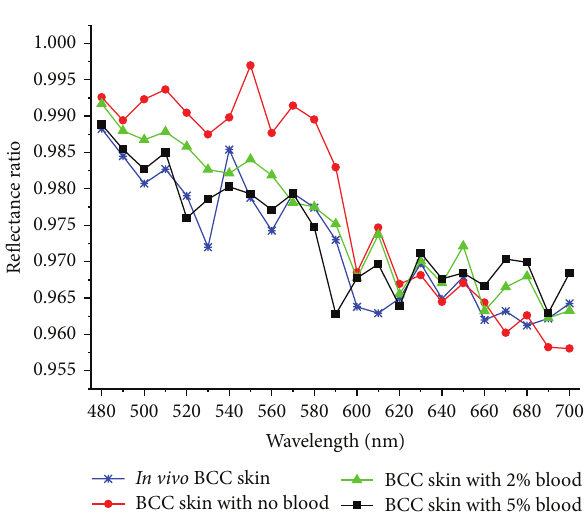
Figure6:Calculatedspectralratiocurvesofexperimentalresultand rebuilt